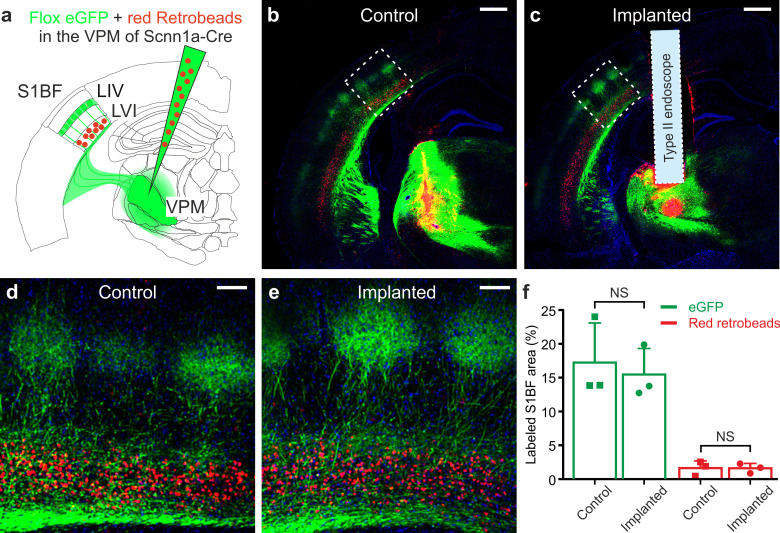
Ultrathin microendoscope implantation preserves thalamo-cortical and cortico-thalamic connectivity between S1bf and VPM.(a) Local injection of red retrobeads and AAVs transducing floxed eGFP was performed in the VPM of Scnn1a-Cre mice. (b) Confocal image showing a coronal slice from an injected control animal. Scale bar: 500 μm. (c) Same as (b) but for a mouse implanted with a type II eFOV-microendoscope (probe diameter: 500 μm). (d,e) Zoom in of the S1bf region highlighted in (b,c). Scale bar: 100 μm. (f) Percentage of labeled S1bf area with eGFP (green) and retrobeads (red) in control and implanted mice. Points indicate the value of fluorescence from three mice (counted three coronal slices from each animal), column bars indicate average ± sd. One-tailed Mann-Whitney, p=0.20 for eGFP and p=0.50 for red retrobeads, respectively.Figure 5—source data 1.Percentage of labeled S1bf area with eGFP and retrobeads in control and implanted mice.